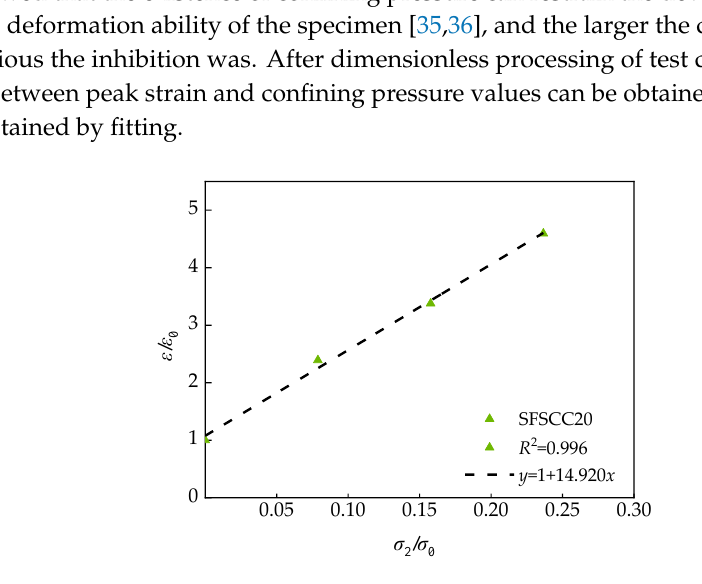
Figure 16. Relationship between peak strain and confining pressure of SFSCC20.